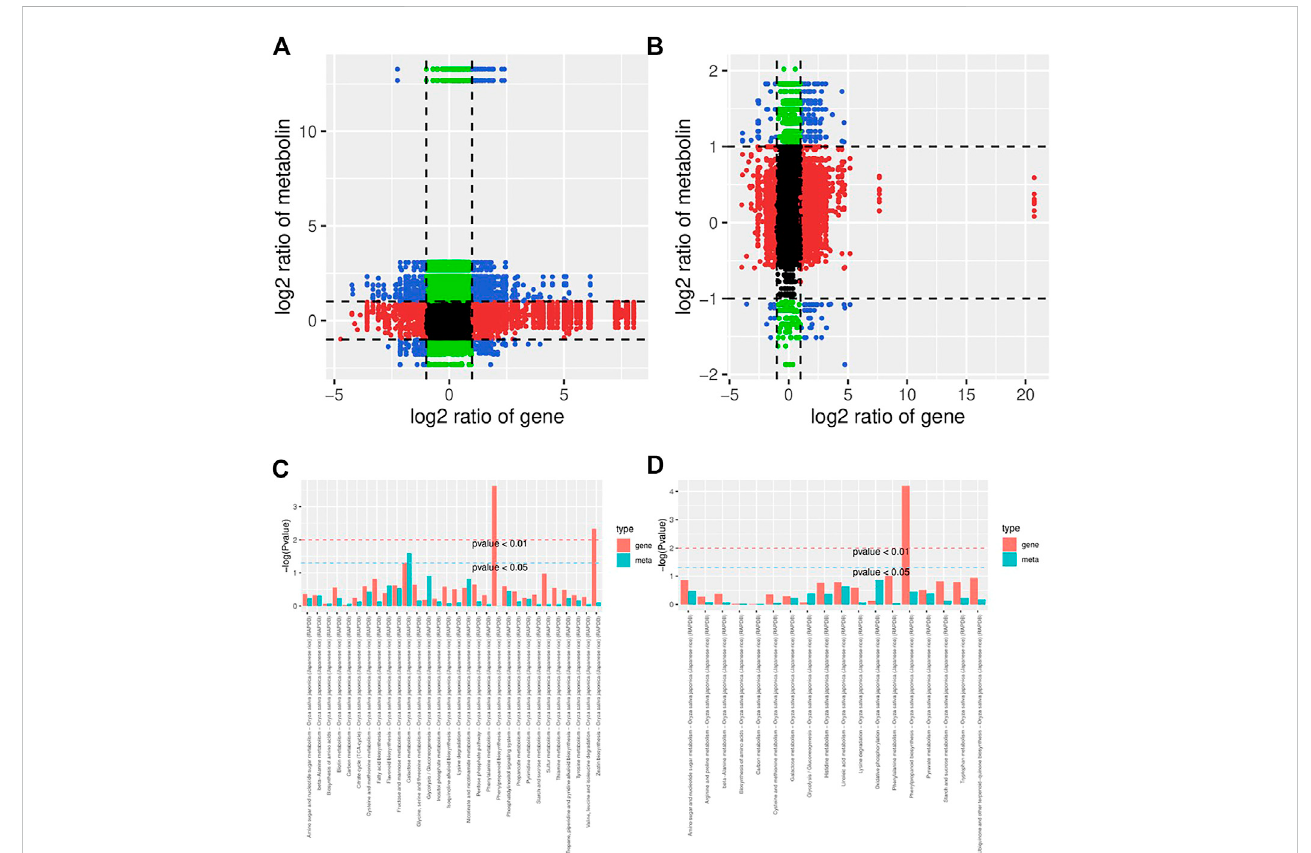
Network analysis of DEGs and DMs of rice roots following Al stress. (A) Nine-quadrant map of genes and metabolites of KR-CK vs. KR-Al. (B) Nine- quadrantmapofgenesandmetabolitesofMR-CKvs.MR-Al. (C) KEGGenrichmentanalysisofdifferentialgenesandmetabolitesinKR-CKvs.KR-Al. (D) KEGG enrichment analysis of differential genes and metabolites in MR-CK vs.